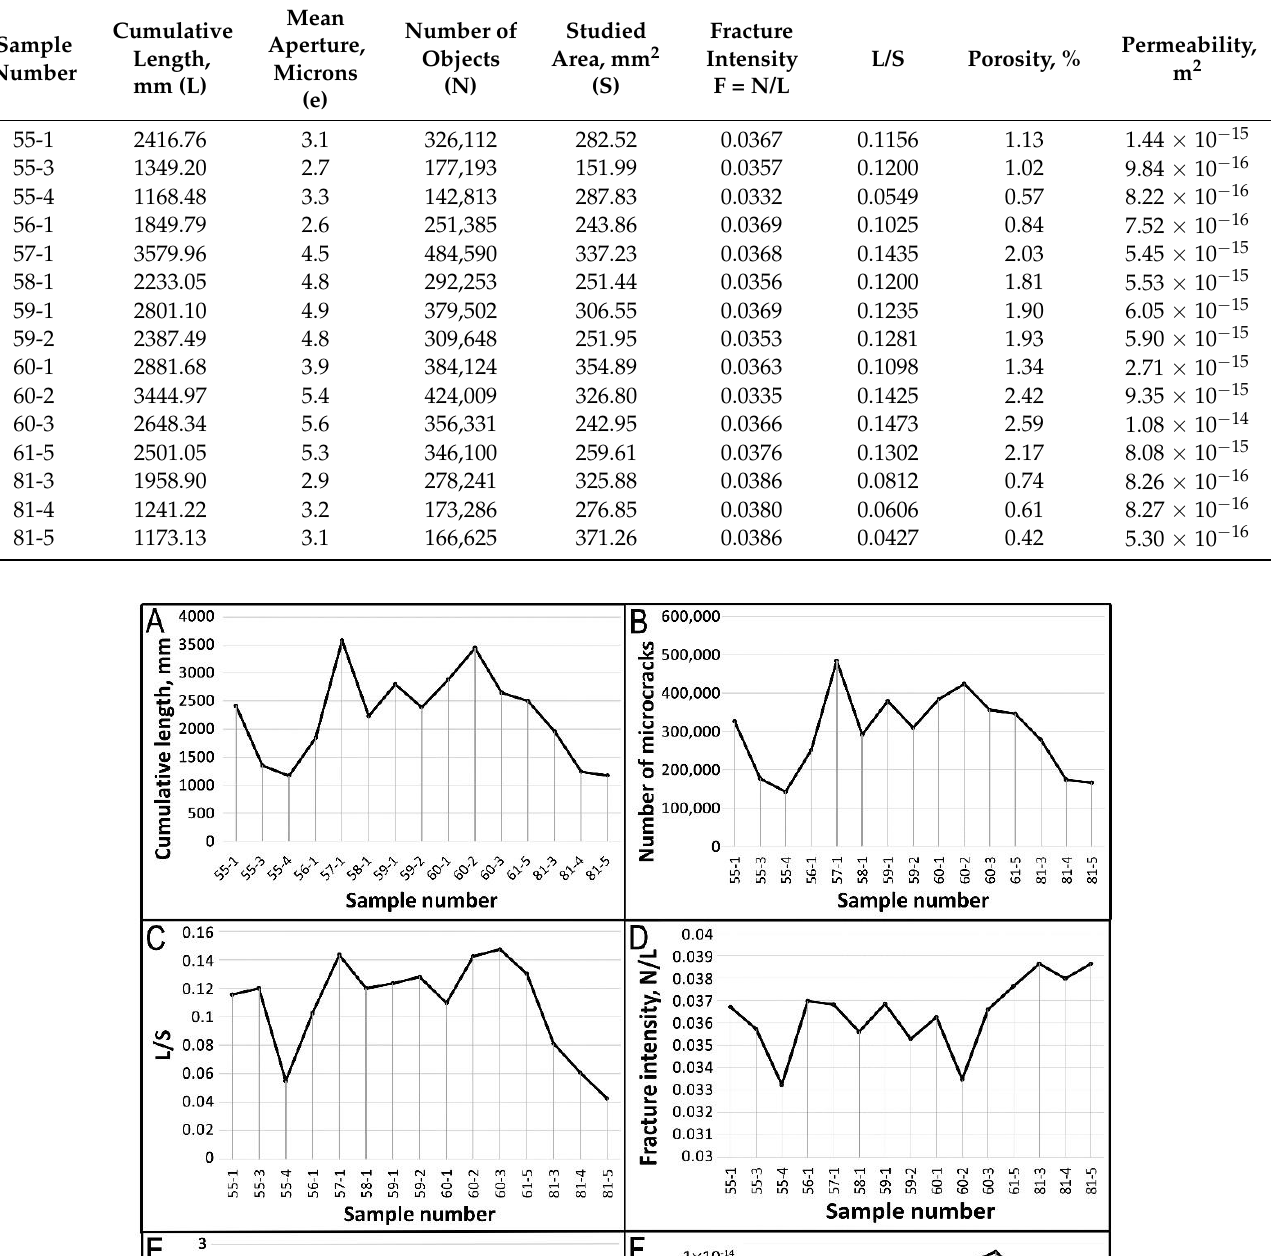
Table 6. Statistical parameters of microfractures.